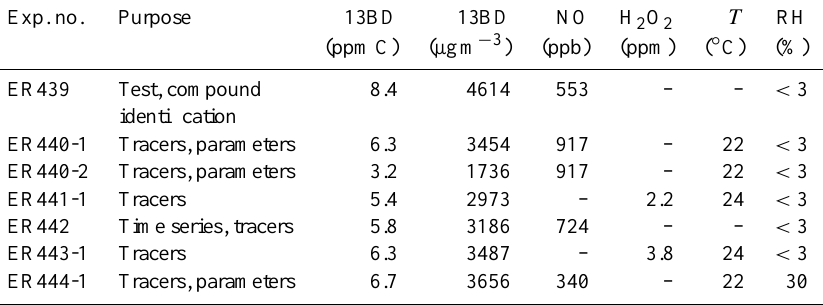
Table 1. Initial conditions for experiments involving 1,3-butadiene (13BD) oxidation. The experiments were conducted with the chamber operated in a dynamic (flow) mode, except for ER439 and ER442 conducted in static (batch) mode. T : temperature; RH: relative humidity. Seed aerosol at 10µgm − 3 was used. GC–MS analysis was done only when NO x was present in the system. Exp.